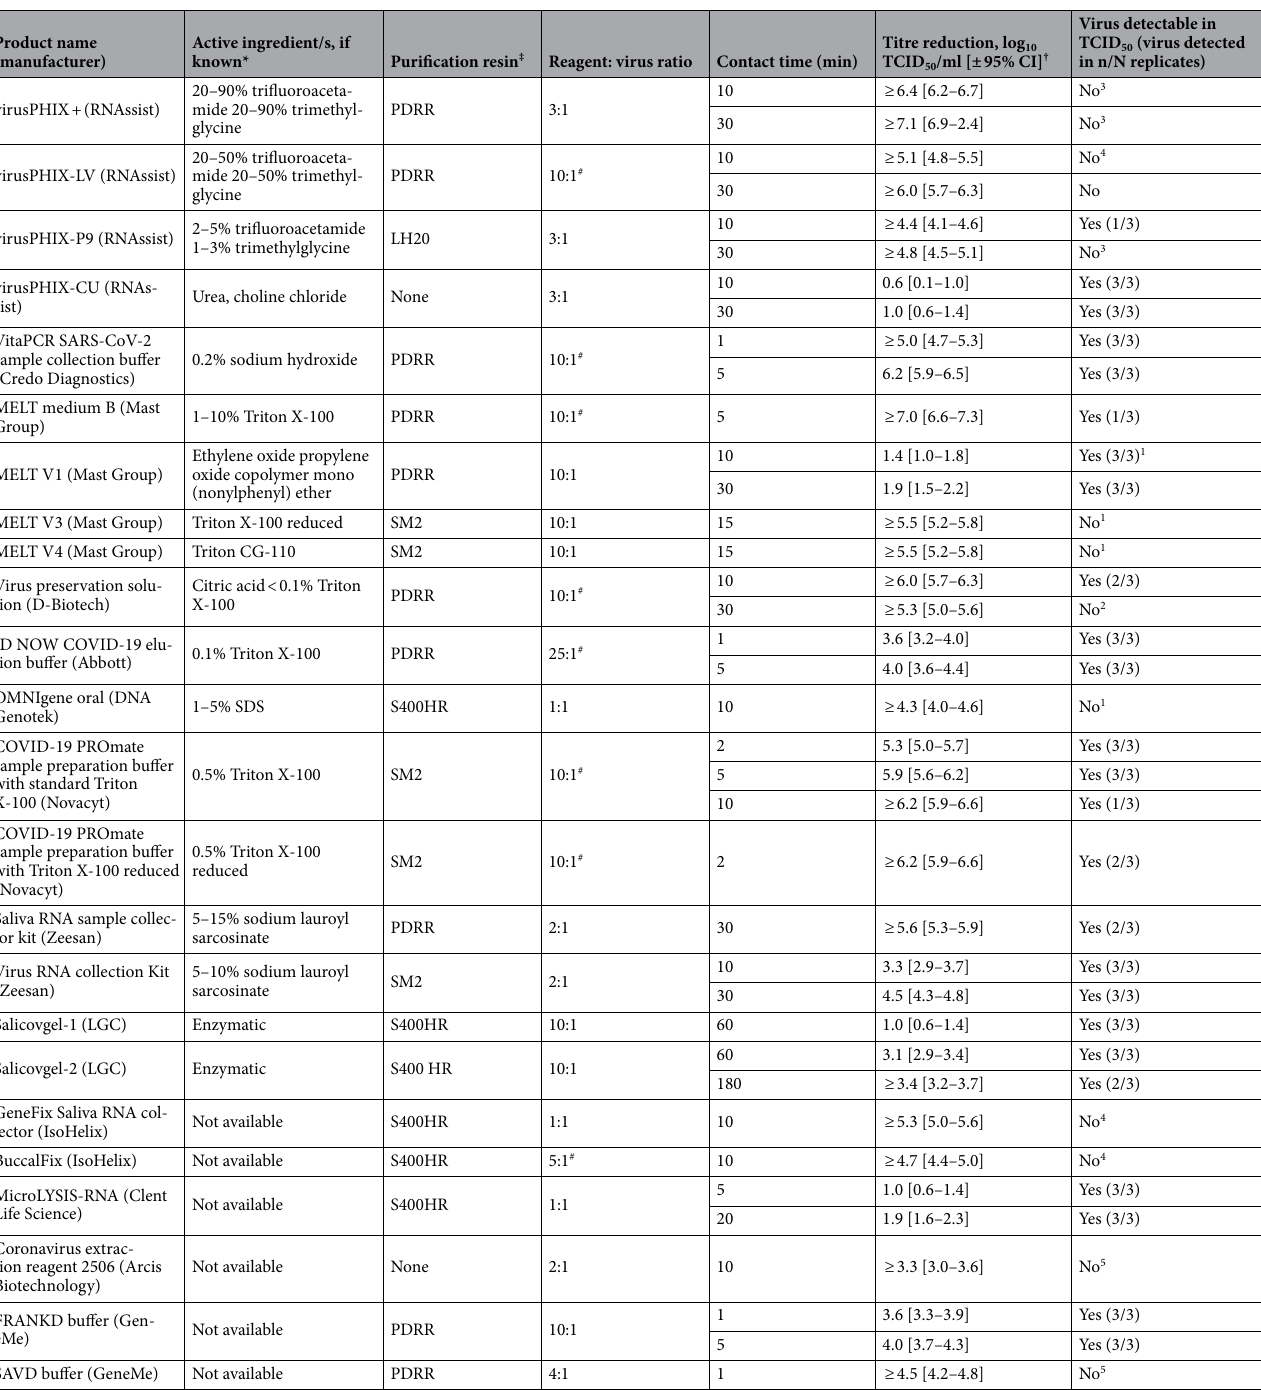
Table 1. SARS-CoV-2 inactivation by guanidine-free nucleic acid extraction reagents. See overleaf for table footnotes. Where identical results were obtained at multiple contact times, only the shortest contact time is shown. *As indicated on product safety data sheets or other product literature. † Values are given as ≥ when at least one replicate was below the limit of detection. # Tested using concentrated virus stock. ‡ PDRR: Pierce Detergent Removal Resin; SM2: Biorad SM2 BioBeads; S400HR: Sephacryl S-400HR; LH20: Sephadex LH-20. STM specimen transport media. Limit of detection: 1 0.7 log 10 TCID 50 /mL; 2 0.8 log 10 TCID 50 /mL; 3 1.0 log